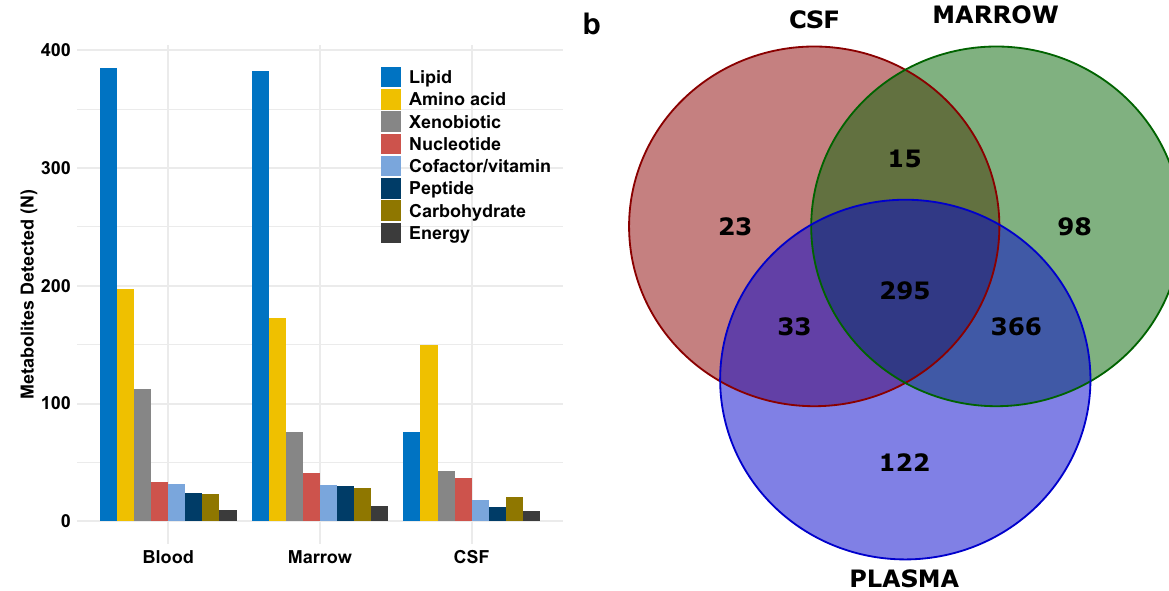
Figure 1. ( a ) Number and class of compounds detected in plasma, bone marrow, and cerebrospinal fluid samples from children with B-ALL. ( b ) Overlap between the plasma, bone marrow, and CSF metabolomes.